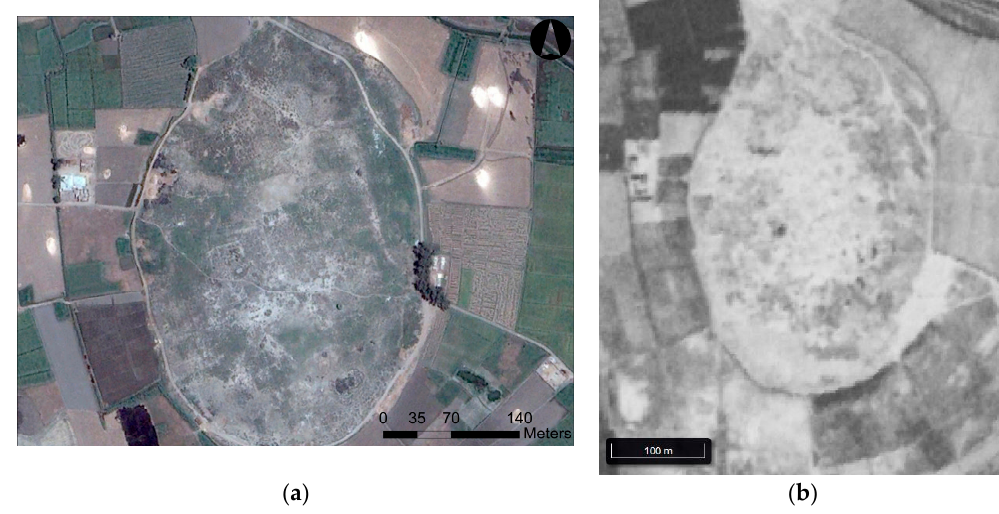
Figure 15. ( a ) The site of Kom el-Barud. Image courtesy Google Earth; ( b ) 1968 CORONA image. Image courtesy of the Center for Advanced Spatial Technologies, University of Arkansas/U.S. Geological Survey.